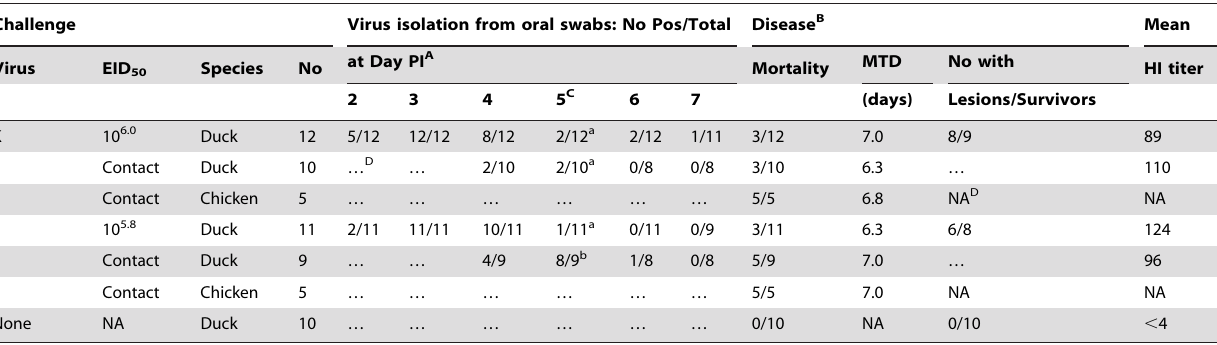
Table 2. Infection of ducks and chickens by inoculation or contact with HP VN/1203/K (K) and HP VN/1203/E (E).